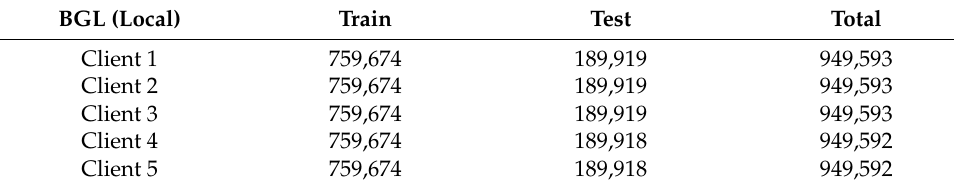
Table 5. BGL datasets for each local server